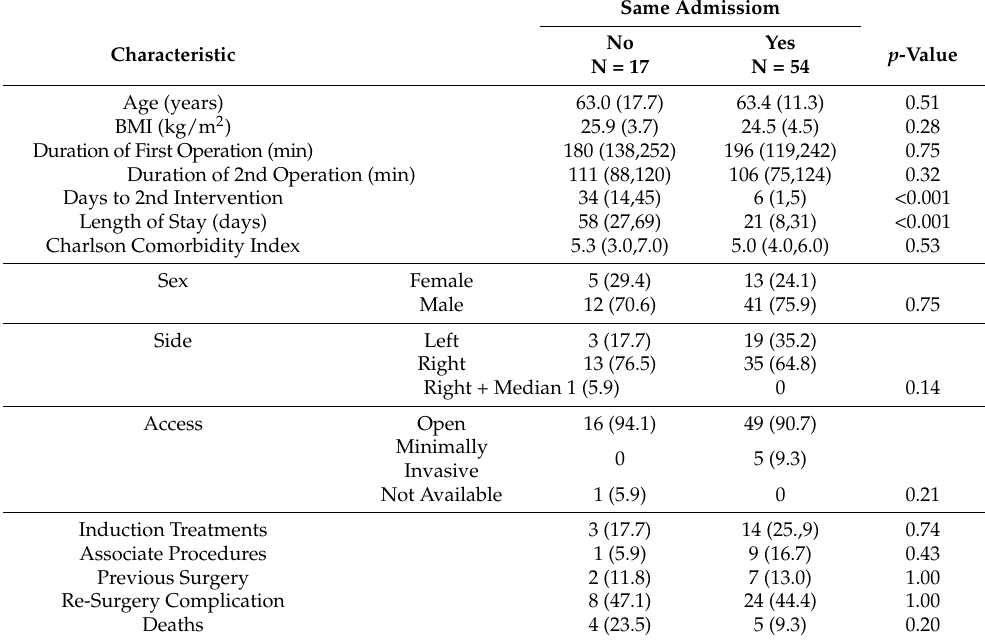
Table 5. Patients’ characteristics and treatments by reoperation during the same admission summary